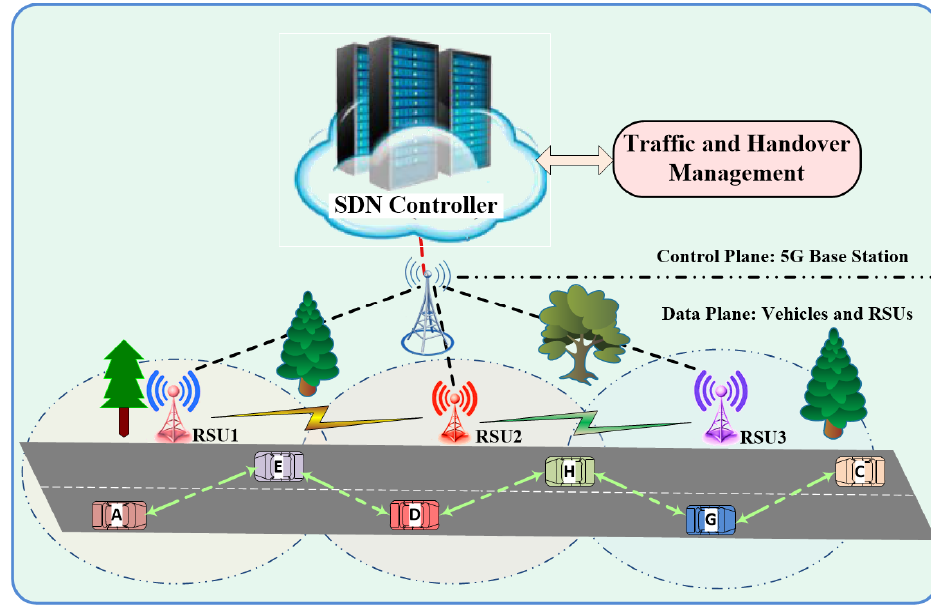
Figure 1. The 5G ‐ VANET Architecture. Figure 1. The 5G-VANET